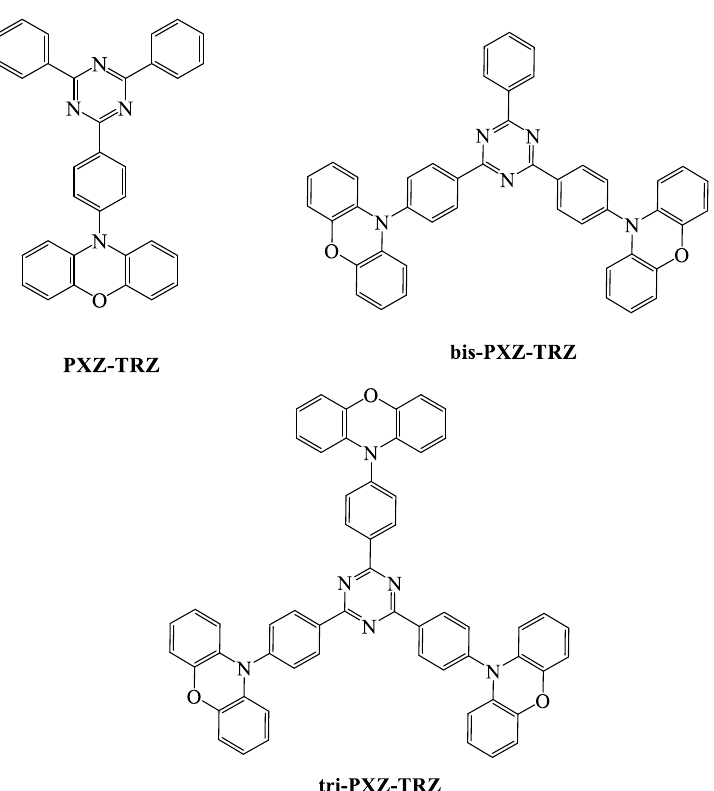
Figure 4. Molecular structures of triazine acceptors with phenoxazine donor moieties. Table 1. Photophysical properties of triazine-based green thermally activated delayed fluorescence